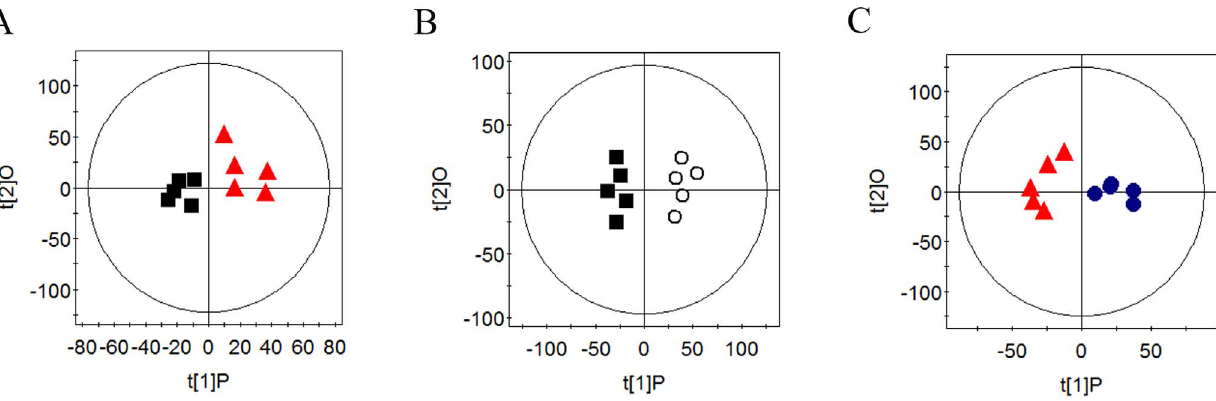
N Fig. 3. OPLA-DA scores for CPMG spectra of NC ( & ), DON ( m ), DG ( ) and GLU ( # ) groups. Dietary treatments were NC, an uncontaminated basal diet, DON, the basal contaminated with 4 mg/kg deoxynivalenol, GLU, uncontaminated basal diet with 2% glutamic acid supplementation, and